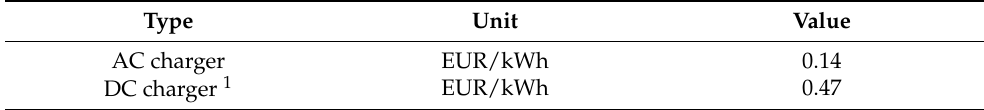
Table 3. Charging cost of electric vehicles.